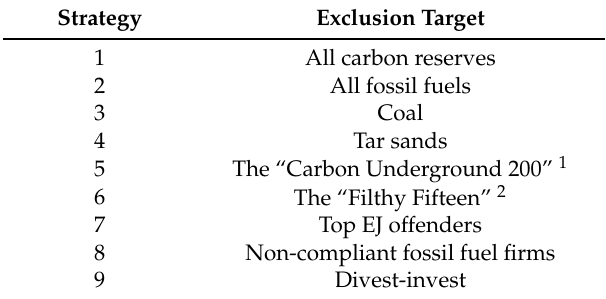
Table 1. Current and proposed divestment strategies.